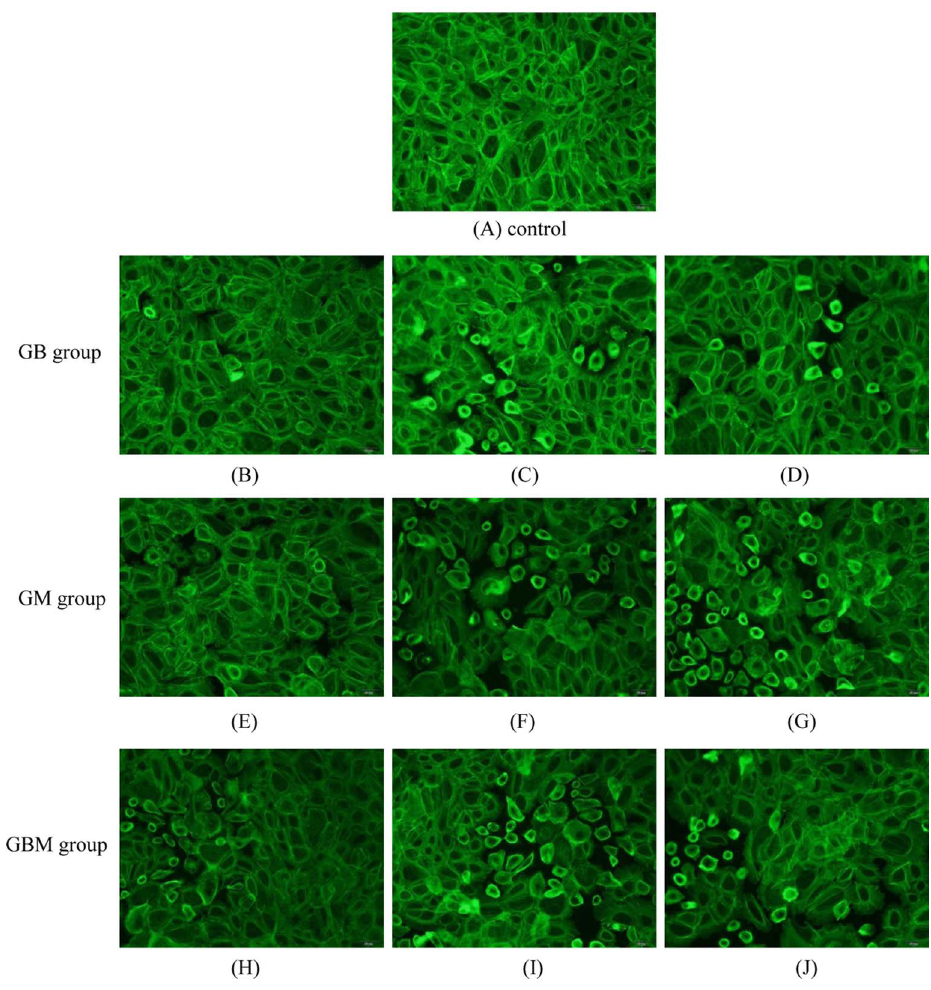
Figure 3. Actin distribution in HNEC monolayer treated with borneol (Bo) and muscone (Mu). (A) 50 m g ? mL 2 1 geniposide (control). (B) (C) and (D) 50 m g ? mL 2 1 geniposide combined with 27.8, 55.6 and 111.2 m g ? mL 2 1 borneol, respectively. (E) (F) and (G) 50 m g ? mL 2 1 geniposide combined with 4.17, 8.34 and 16.68 m g ? mL 2 1 muscone, respectively. (H) (I) and (J) 50 m g ? mL 2 1 geniposide combined with borneol and muscone (Bo 27.8 and Mu 4.17 m g ? mL 2 1 , Bo 55.6 and Mu 8.34 m g ? mL 2 1 , Bo 111.2 and Mu 16.68 m g ? mL 2 1 , respectively). Scale bar: 20 m m.